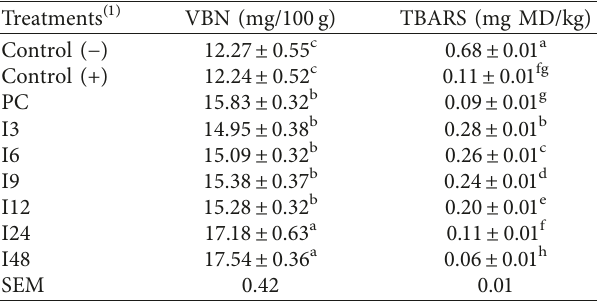
Table 3: Changes of VBN and TBARS of cooked cured pork loin with spinach juice and different incubating periods.